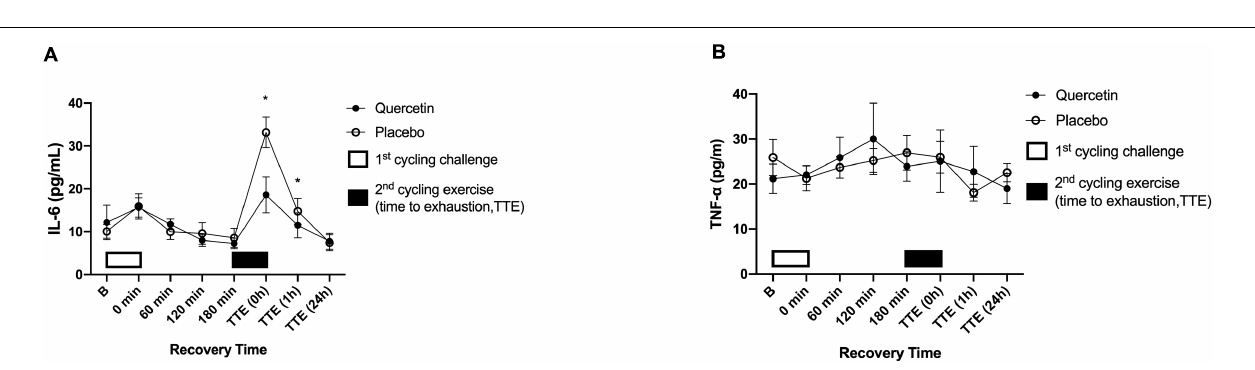
FIGURE 5 | Serum total antioxidant capacity (TAC) (A) , superoxidase dismutase (SOD) (B) , and malondialdehyde (MDA) (C) concentrations in (- ◦ -) placebo and (- • -) quercetin trials. B represents before the first cycling challenge. TTE (0h,1h): represents immediately, and 1-h after the second cycling exercise, respectively. *Significant difference between quercetin and placebo ( p < 0.05). Values are expressed as mean ± SE, N = 12.